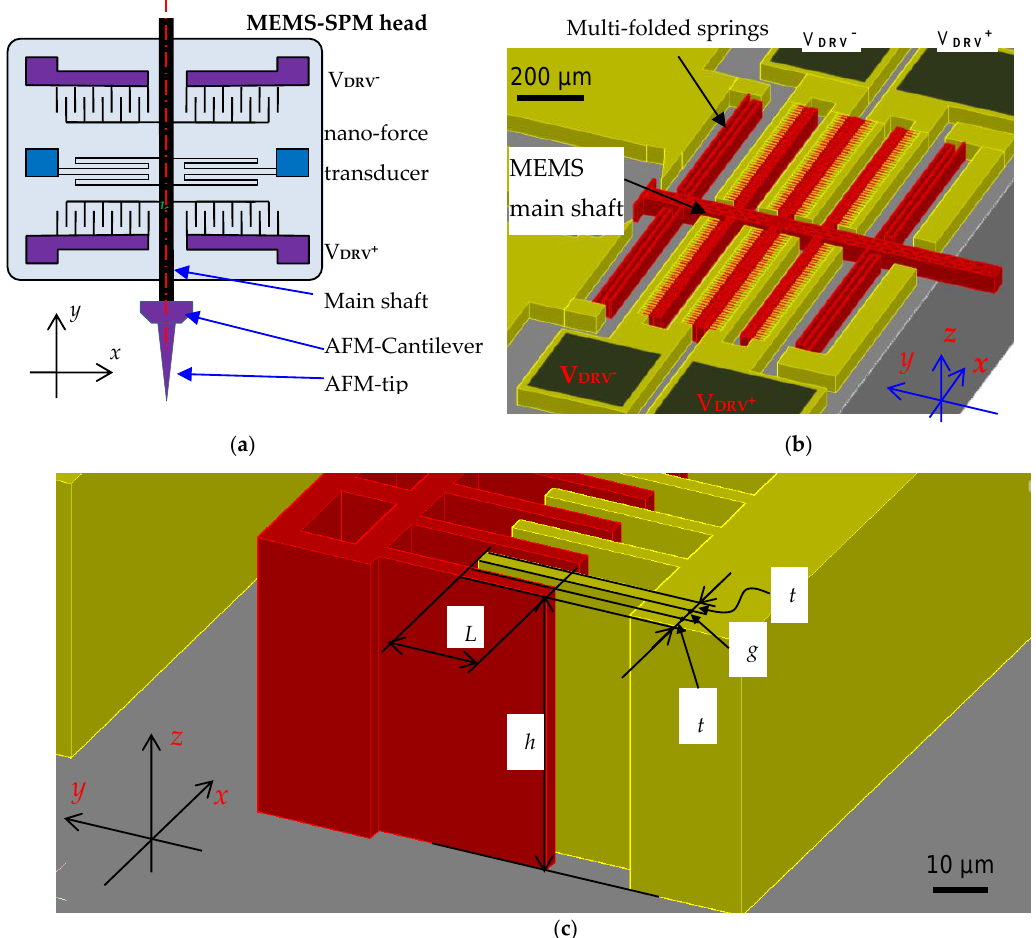
Figure 1. Design of a microelectromechanical system based scanning probe microscope (MEMS-SPM) for quantitative nanomechanical characterization of nanopillars: ( a ) Schematic diagram of the MEMS-SPM, where an atomic force microscopy (AFM) probe was glued onto the end of the shaft; ( b ) 3D-design of the MEMS nano-force transducer; ( c ) detailed view of the MEMS finger pairs, where L is the overlap length of the comb finger pairs, h is the vertical height of the fingers, t is the in-plane thickness of the fingers, and g is the gap of the comb pairs.